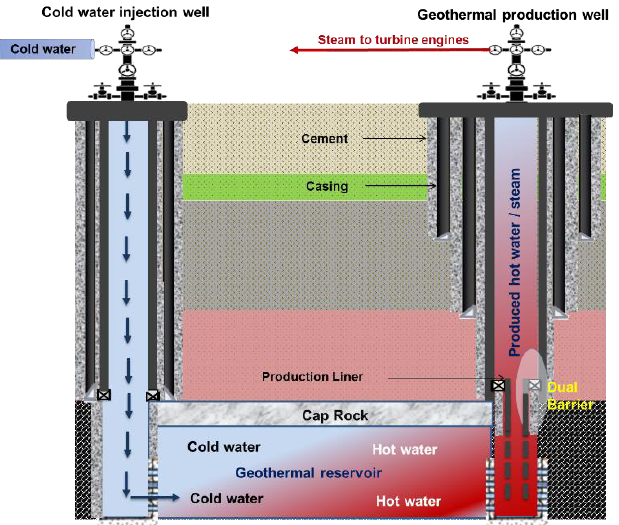
Figure 1. Geothermal well for the production of energy [15].